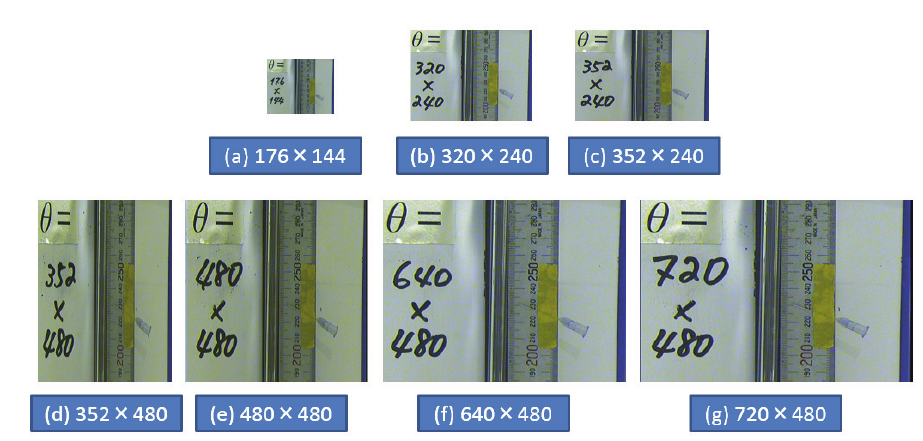
Fig. 5. Magnitude comparison of the image by picture resolution; the number of pixels is the following, respectively,